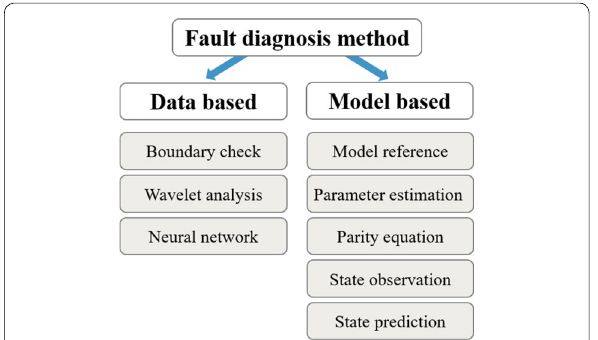
Figure 19 Common methods in fault diagnosis of electro-hydraulic